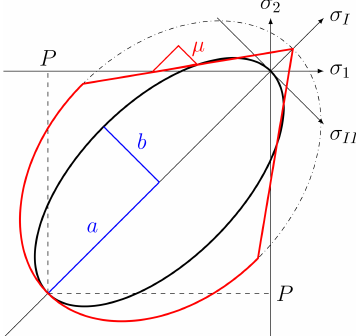
Figure 1. Elliptical yield curve (black) with ellipse aspect ratio e = a/b = 2. Coulombic yield curve (red) and elliptical capping with internal angle of friction ( µ ). Both e and µ are measures of the shear strength of the material. The normal flow rule applies only to the elliptical part of the yield curves. For the two straight limbs of the Coulombic yield curve, the flow is normal to the truncated ellipse (dashed-dotted line) with the same first stress invariant. Note that the axes σ 1 , σ 2 and σ I , σ II do not have the same scale.